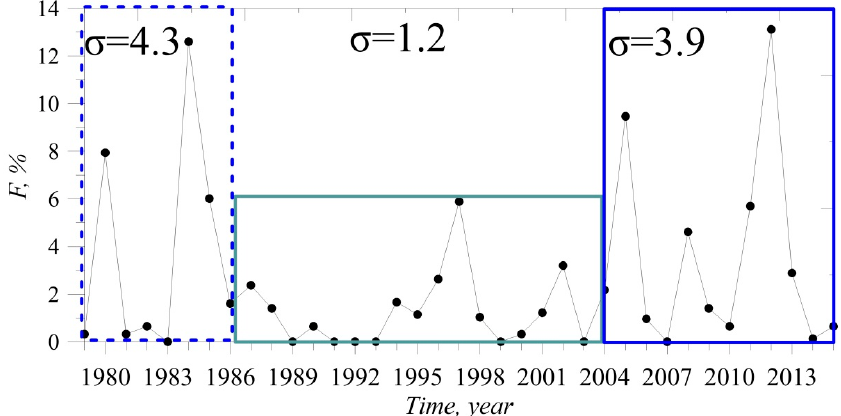
Figure 1. Interannual time-series of the wintertime (November 1 through March 1) blocking frequency over Western Siberia for 1979–2016.